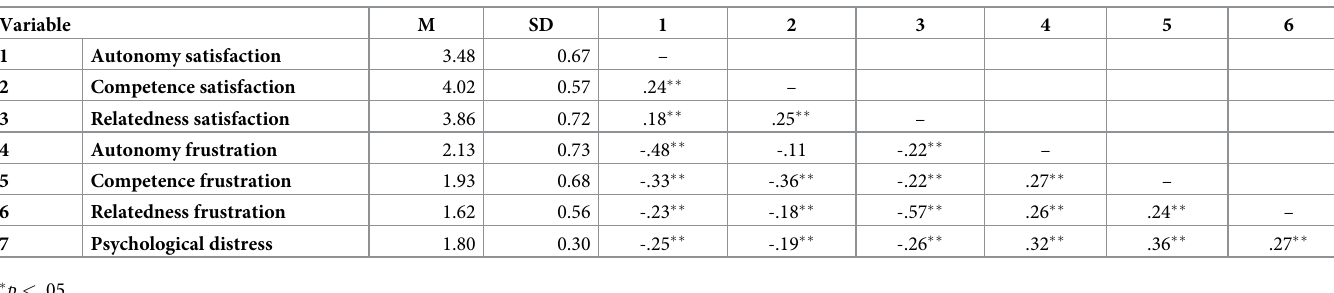
Table 1. Means, standard deviations, and correlations between the study variables.